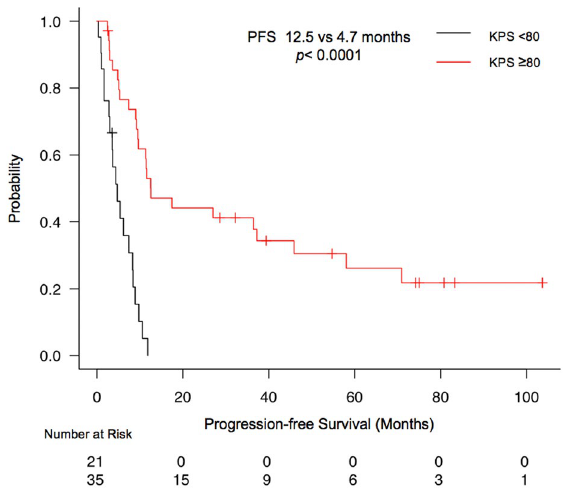
Figure 1. Kaplan–Meier plot of PFS in relation to preoperative